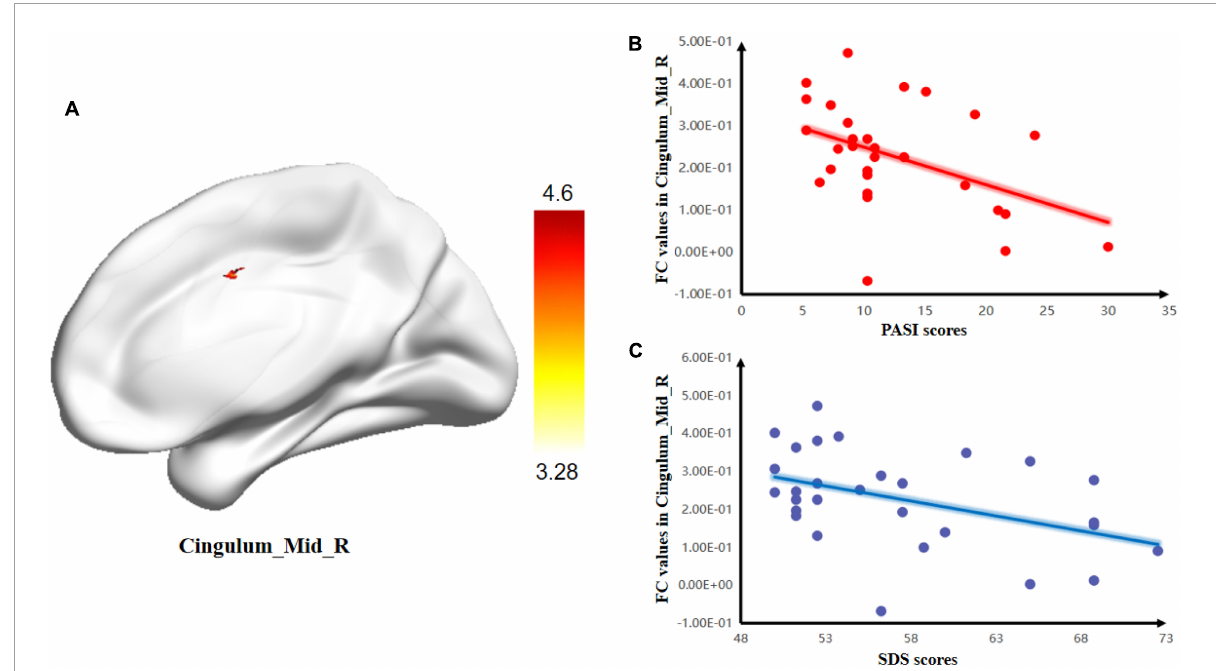
FIGURE2 Group differences in the relationships between brain activity and clinical symptoms. (A) Comparison between psoriasis patients with depression and healthy controls (HCs) for mean resting-state connectivity between the hypothalamus-R and Cingulum_Mid_R. The color bars indicate T -values. Correlations between FC values and PASI and SDS scores. (B) Negative correlation between the mean resting-state connectivity values and PASI scores; (C) Negative correlation between FC values and SDS scores.